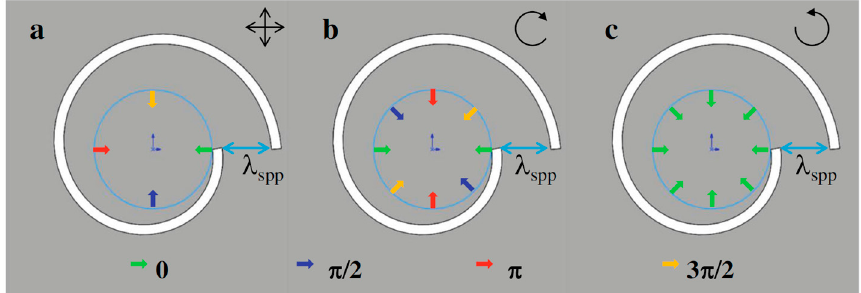
Figure 2. Schematic diagram of the phase of the generated surface plasmon polariton (SPP) wave at the virtual contour with the dashed black line inside the left-handed ASS by: ( a ) radial polarized light; ( b ) left circular polarization (LCP) incidence; the topological charge of the SPP vortex is j pv = 2; ( c ) right circular polarization (RCP) incidence; the topological charge of the SPP vortex is j pv = 0. Reproduced with permission from [28]. Copyright Springer, 2015.